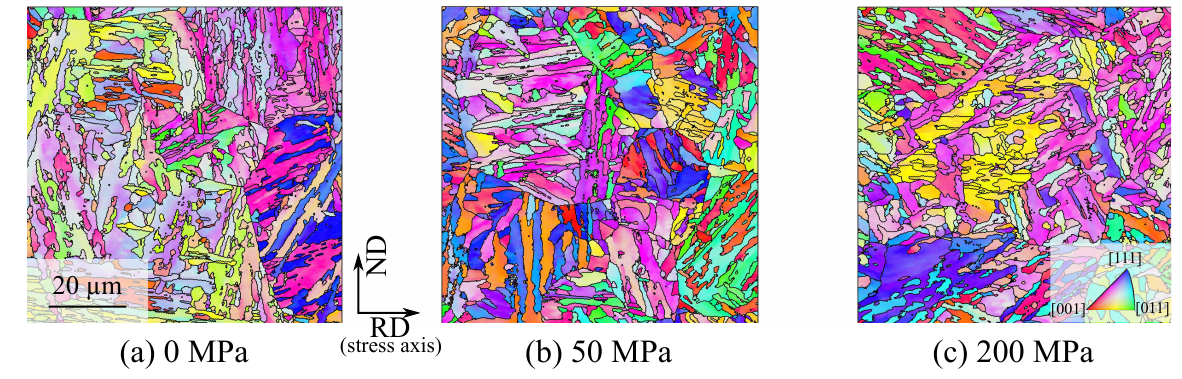
Figure 3. EBSD results of the bainitic transformations at 450°C under applied stresses—( a ) 0 MPa, ( b ) 50 MPa, ( c ) 200 MPa.